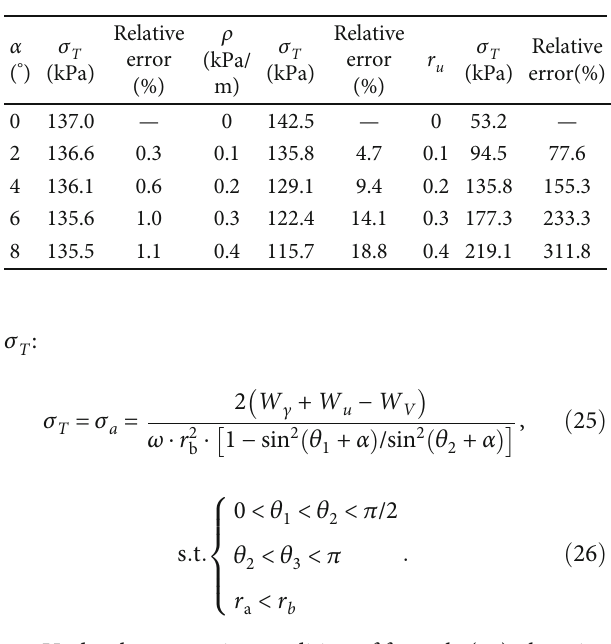
Table 1: Comparison of